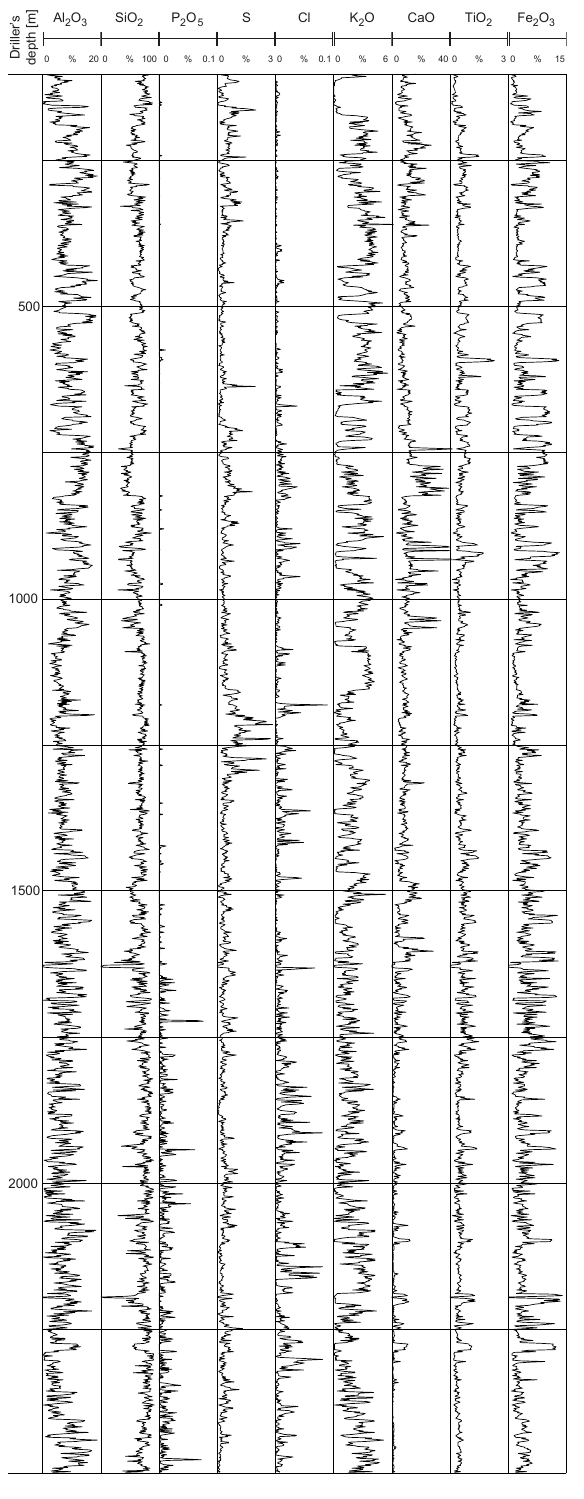
Figure 2. Preliminary chemical data of major elements produced by the new instrument of the full length of the COSC-1 drill core, scanned with 0.1m